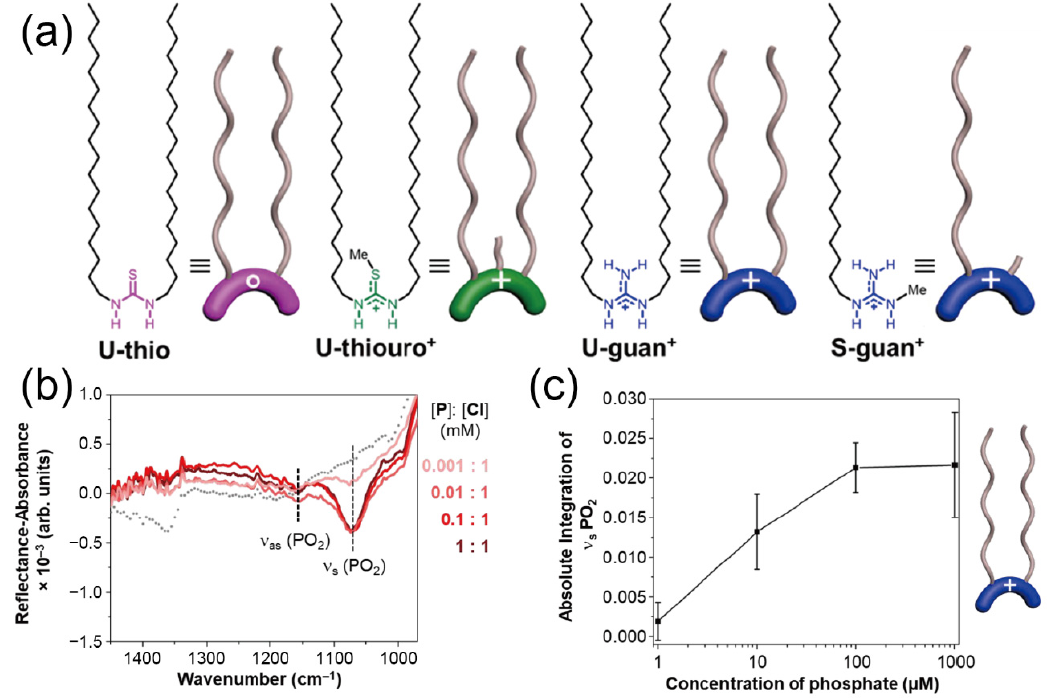
Figure 11. ( a ) Structures of a thiourea-based receptor ( U-thio ), a thiouronium-based receptor ( U-thiouro + ), and guanidinium-based receptors attached with the double-chain ( U-guan + ) and the single-chain ( S-guan + ). ( b ) IRRAS spectra of the U-guan + film upon the addition of analytes. ( c ) Changes in the absolute integration of the ν s (PO 2 ) in the U-guan + film by adding phosphate. Reproduced and adapted with permission from reference [45]. Copyright 2019 American Chemical Society.